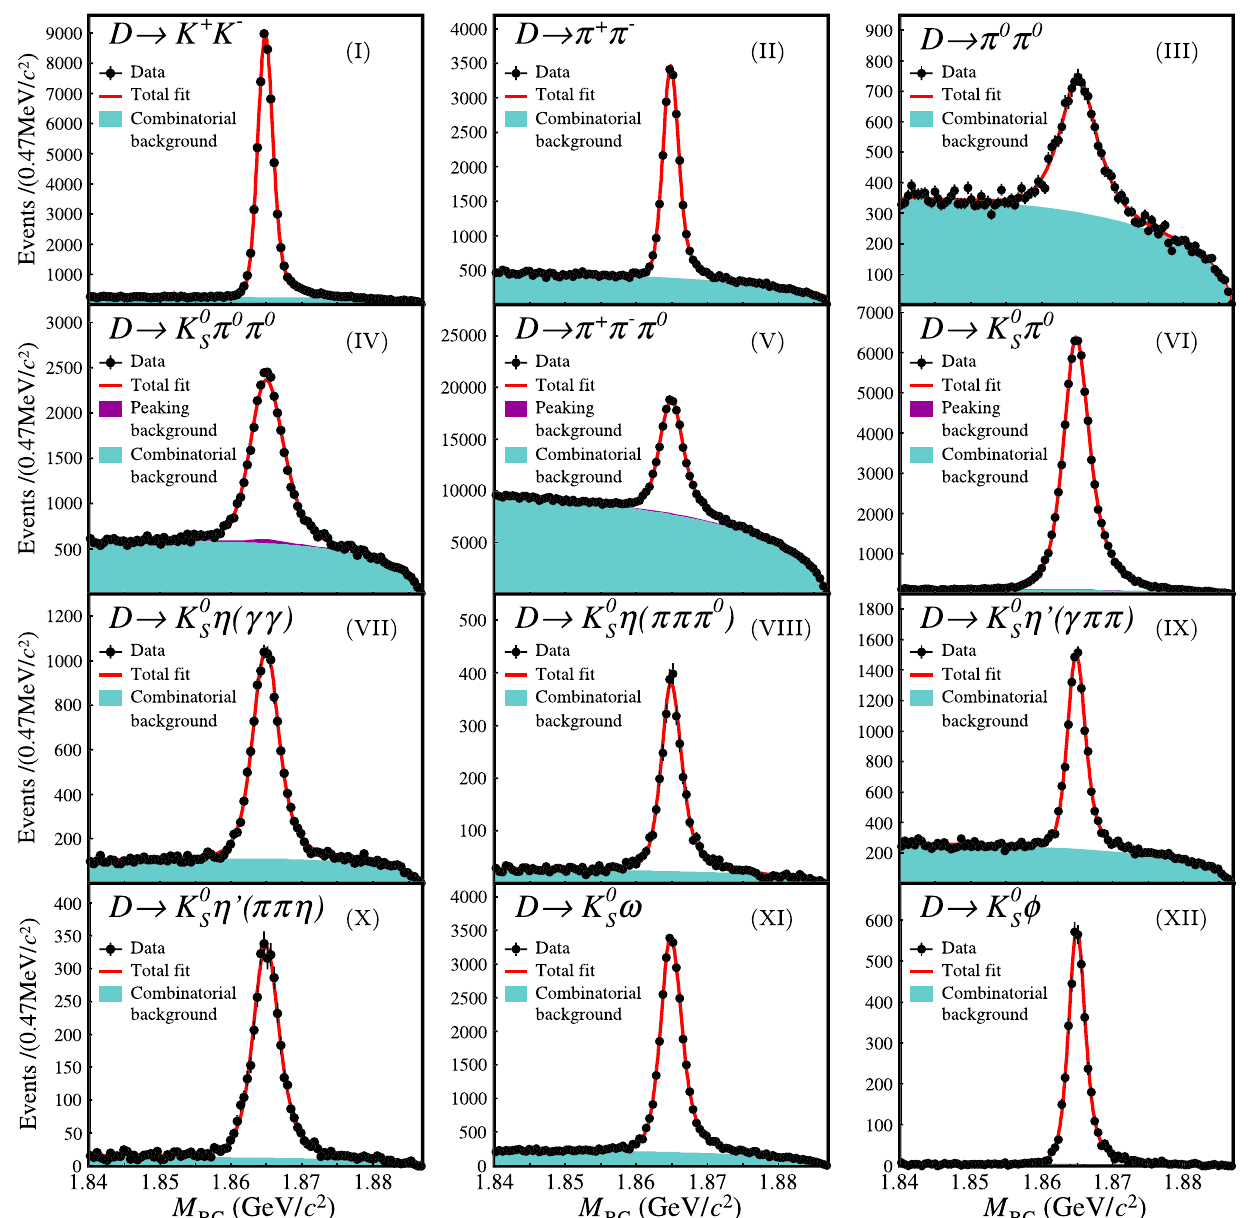
Fig. 2 Fits to M BC distributions of single-tag candidates for the CP -even (I–IV), quasi CP -even eigenstate (V) and CP -odd eigenstates (VI–XII) The D + , D X and D − → K − π + branching fractions are displayed in Fig. 4 for each tag. A least-squared fit is per- formed for the CP eigenstates, taking account of the sys- tematic uncertainties and their correlations, which yields B ( D − → K − π + ) = ( 4 . 445 ± 0 . 060 ± 0 . 056 ) % with a fit quality per number of degrees of freedom (n.d.f.) of χ 2 / n . d . f . = 11 . 1 / 5 and B ( D + → K − π + ) = ( 3 . 406 ± 0 . 059 ± 0 . 038 ) % with χ 2 / n . d . f . = 10 . 4 / 7. Here the first uncertainty is statistical and the second systematic. The branching fraction obtained with the D → π + π − π 0 tag is